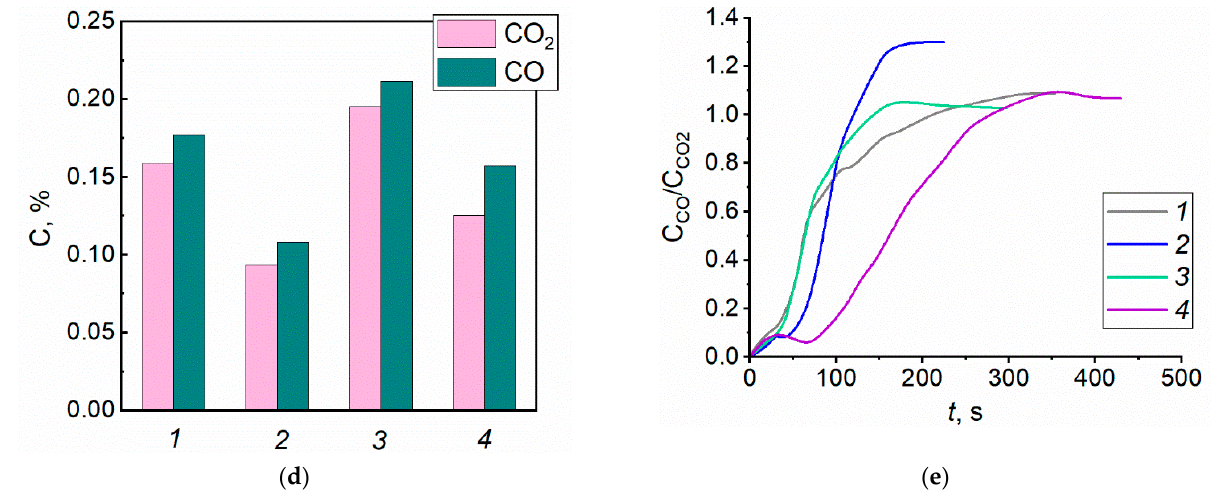
Figure 6. Trends of CO 2 ( a ) and CO ( b ) recorded in the suppression of laboratory-scale timber fires using different fire extinguishing compositions. ( c ) Suppression times of laboratory-scale timber fires using different fire extinguishing compositions. ( d ) Average concentrations of flue gas components during the suppression of burning timber with different fire extinguishing compositions. CO/CO 2 ratios in the suppression of burning timber with di ff erent fi re extinguishing compositions ( e ): 1— bentonite slurry; 2 —bischo fi te solution; 3 —foaming agent solution; and 4 —water.